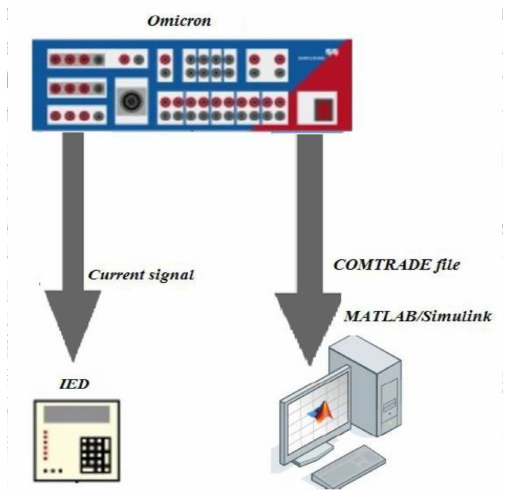
Figure 1. The test structure.